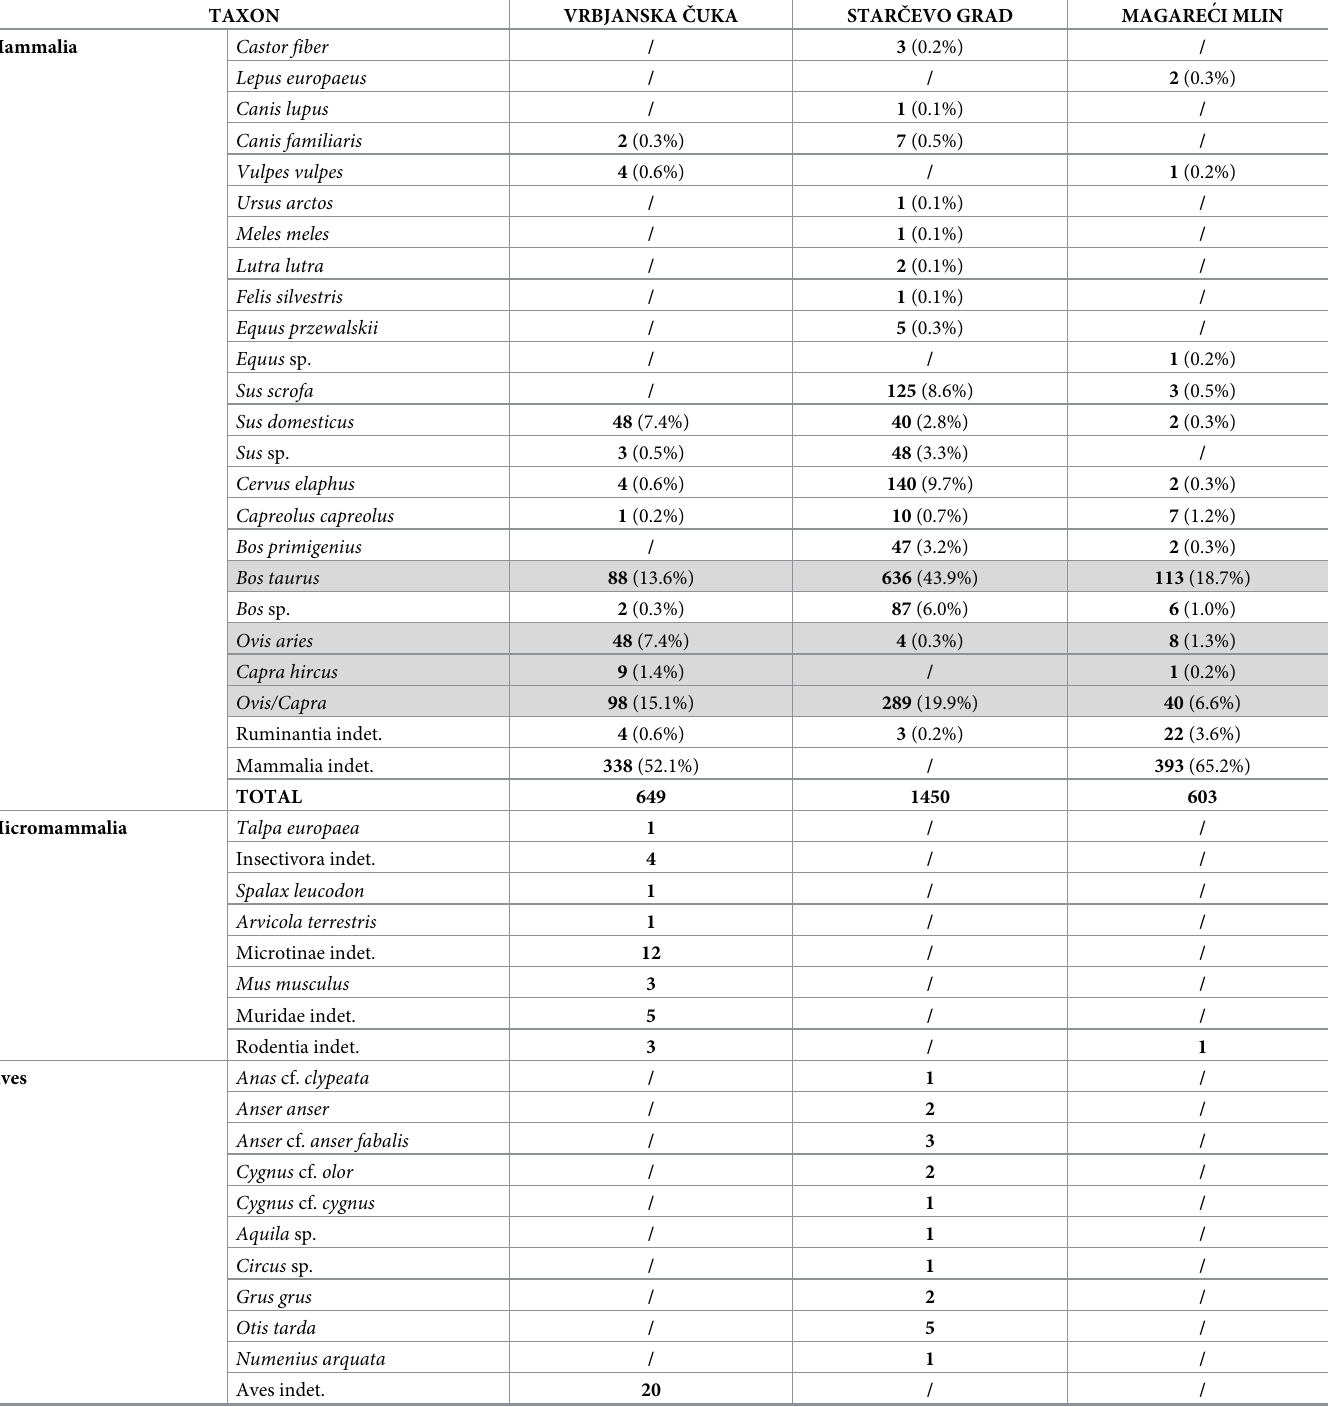
Table 1. The taxonomic composition of faunal assemblages from the sites of Vrbjanska Č uka and Magare ć i Mlin (analysed within this study) and Star č evo-Grad (analysed by Clason 1980), expressed in NISP (number of identified specimens) frequencies.